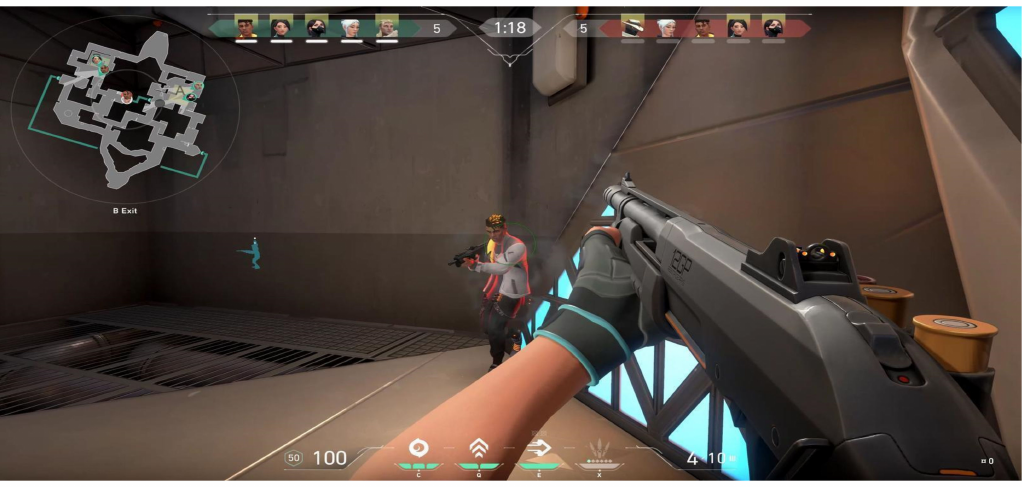
Figure 4. A duel in Valorant.